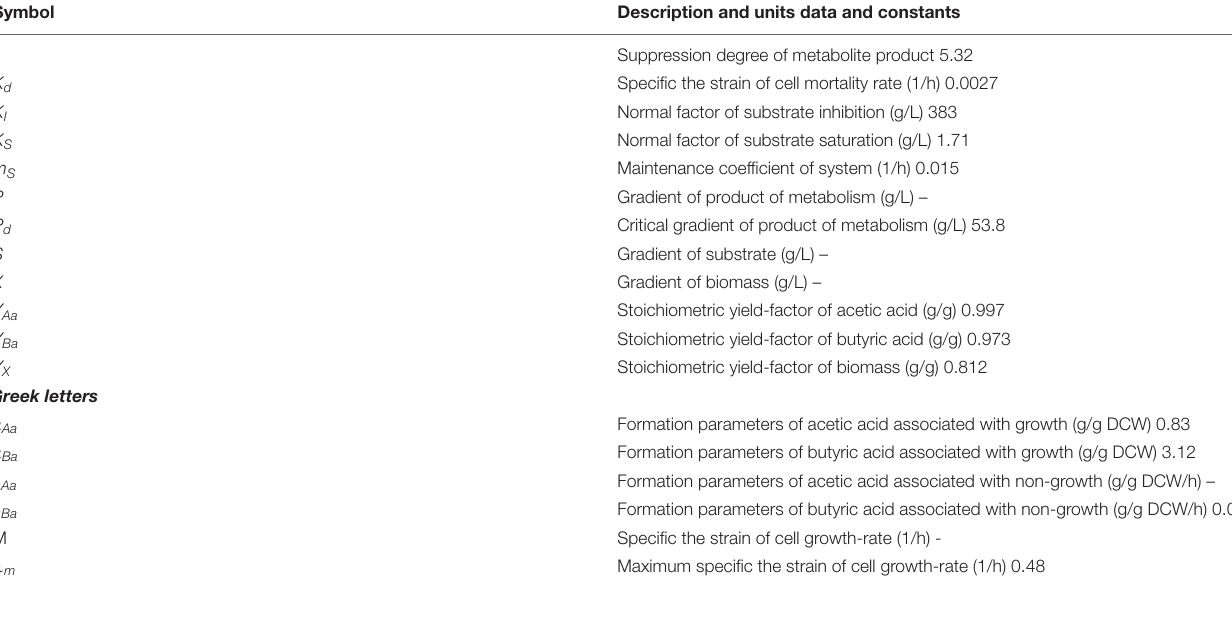
TABLE 4 | Notations, units for Equations (2–5 and 15), parameters, data and constants. Symbol Description and units data and constants Suppression degree of metabolite product